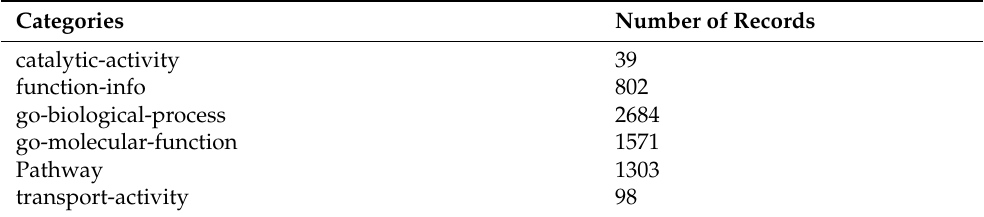
Table 1. Categories of functional annotation and the number of records for 1441 proteins whose functions were first annotated in one of the versions of neXtProt over the past five